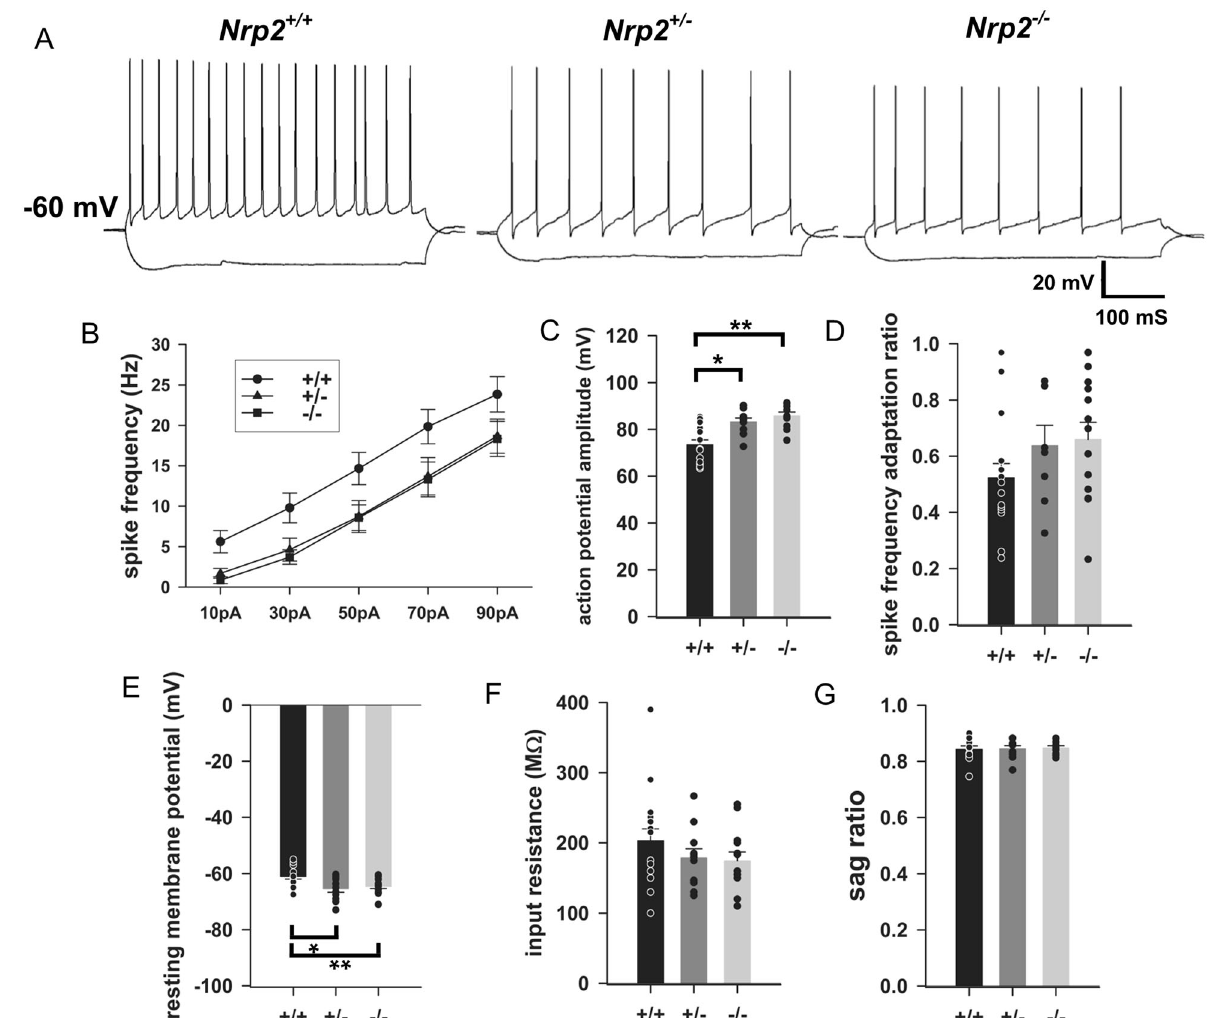
Nrp2 + / + ( n = 17), Nrp2 + / − ( n = 11), and Nrp2 − / − ( n = 13). Signi fi cant effect of genotype F (2,38) = 4.006, p = 0.026 by two-way repeated measures ANOVA and p < 0.05 for pairwise comparison Nrp2 + / + and Nrp2 − / − using Holm-Sidak method. C – G Summary plots of Action Potential Amplitude ( C ) Spike Frequency Adaptation Ratios (D), Resting Membrane Potential ( E ), Input Resistance ( F ), and Sag Ratio ( G ). n = 16 – 17 for Nrp2 + / + , 8 – 11 for Nrp2 + / − and 11 – 13 for Nrp2 − / − . *indicates p < 0.05 one-way ANOVA followed by pairwise comparison using Holm-Sidak method. Data presented as